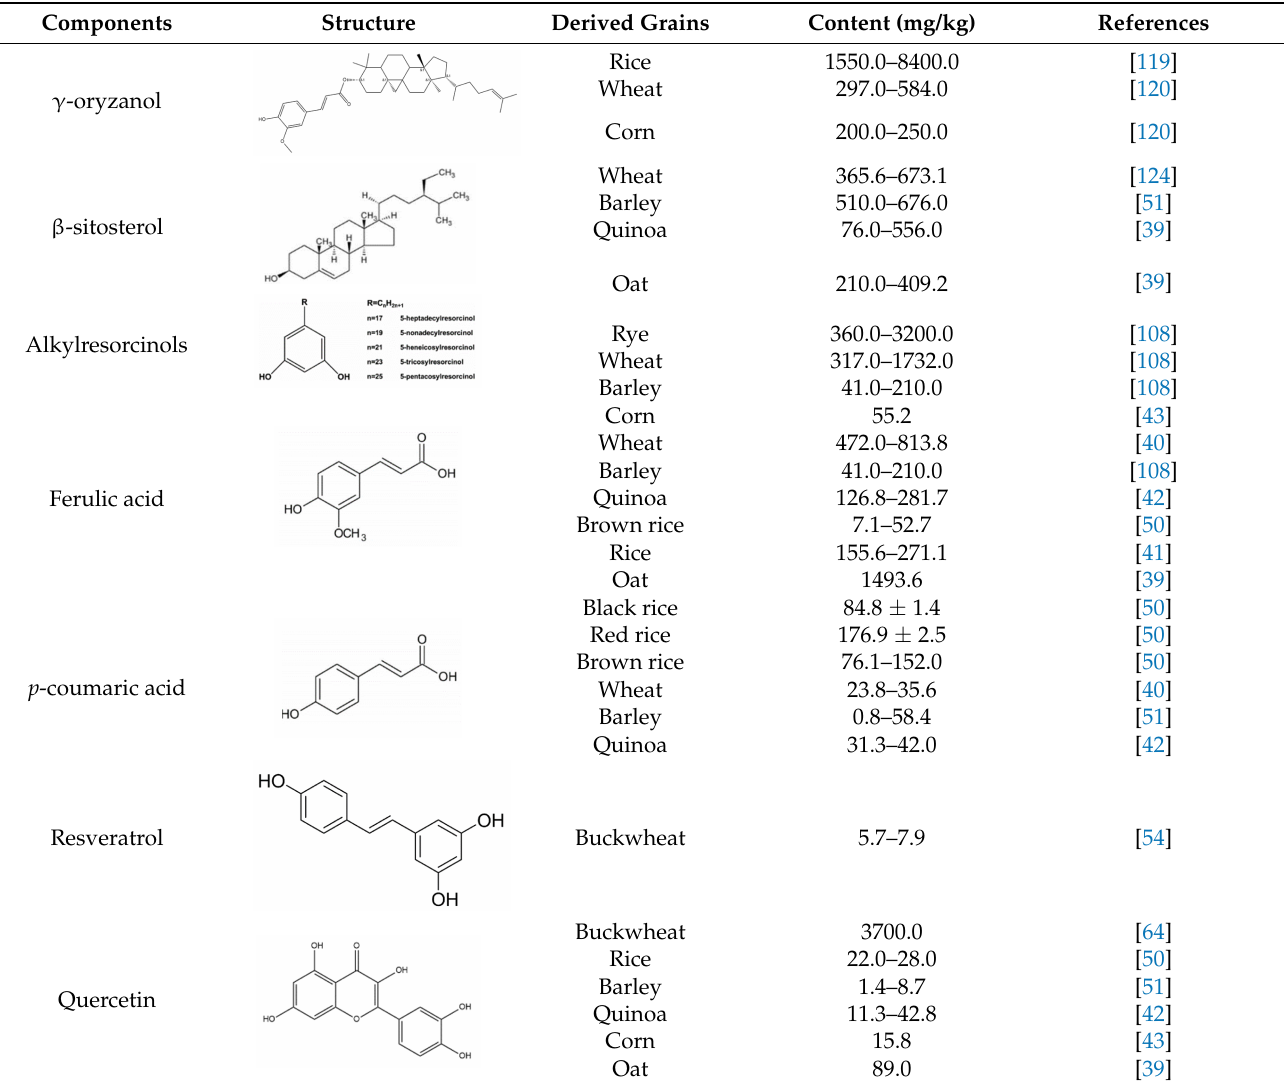
Table 1. The structure and content of bioactive components in whole